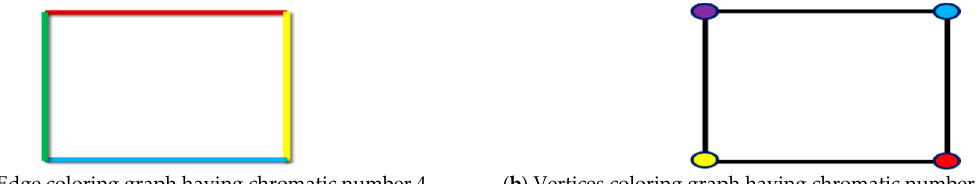
Figure 19. Overview of the colored graphs (vertex and edges).